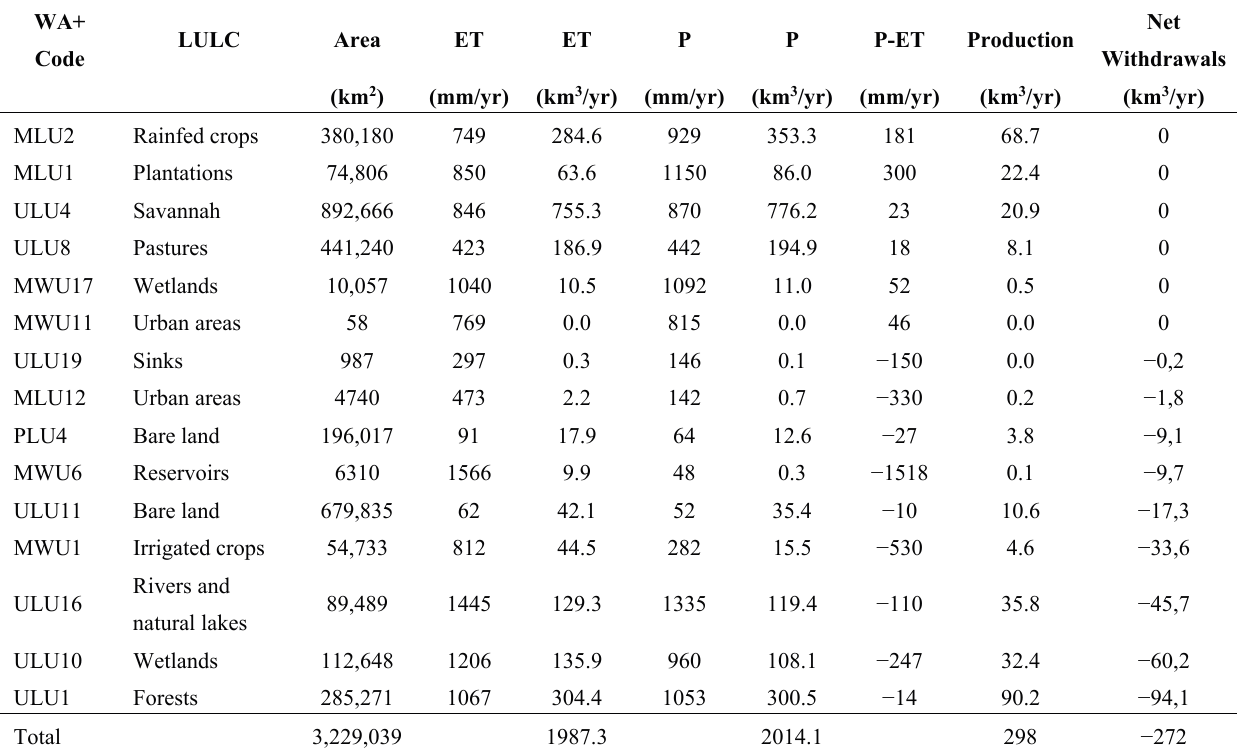
Table 5. Water production and consumption by land use-land cover class in the entire Nile basin for the period 2005–2010. Production was computed as P-ET when P > ET. For cases with ET > P, production was computed as 0.3 P. Net withdrawal was computed as ET-0.7